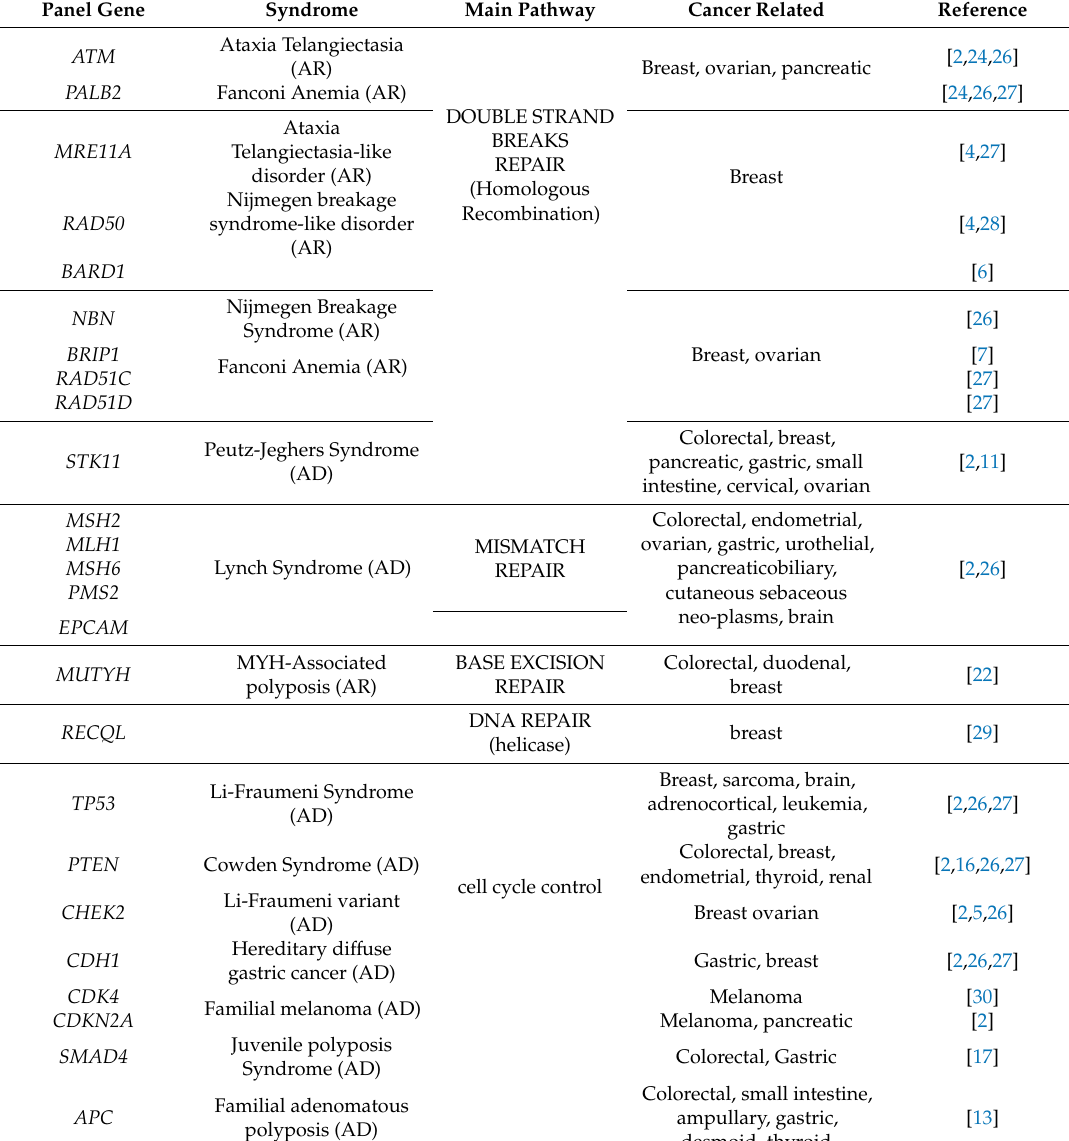
Table 1. DNA damage repair (DDR) genes analyzed in this